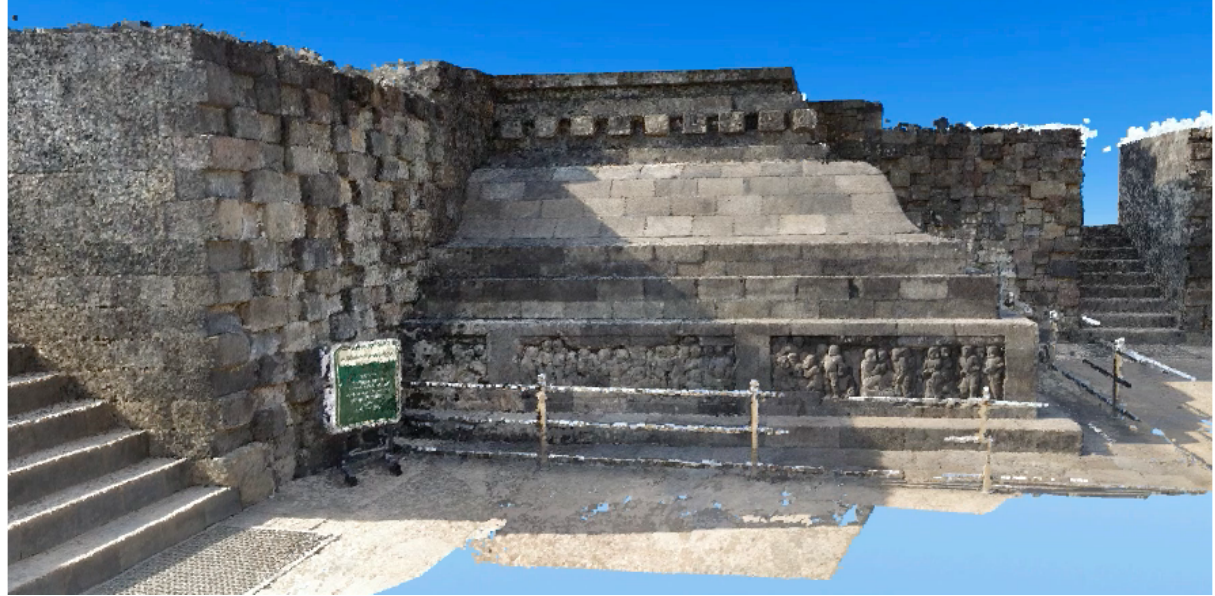
Figure 8. First-person view of the Borobudur Temple viewed in our VR system.